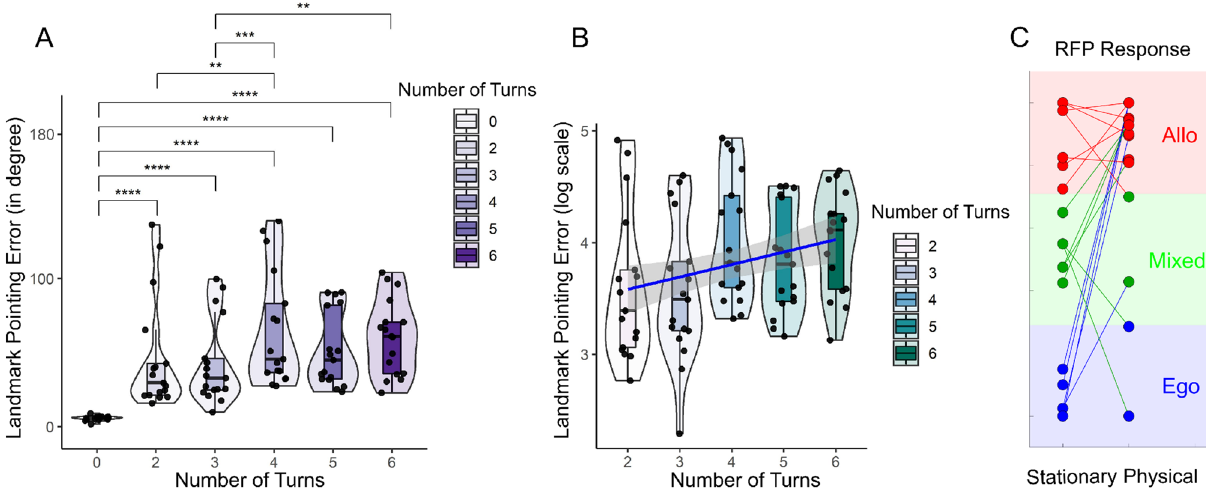
Figure 2. The results of participant behaviour. ( A ) Participant behavior in the landmark pointing task (using R software 33 ). The X axis indicates the number of turn points in the trial, the Y axis indicates the absolute error of the participants when they performed the landmark pointing task (the error was measured by the angular difference between the pointing vector and the participant to landmark vector) (*, **, ***, **** indicated for p <.05, p <.01, p <.001, p <.0001 respectively, FDR-corrected). ( B ) The result of mixed-effects model analysis (using lme4 34 , and lmerTest package 35 ), the regression was visualized by the blue line. ( C ) The RFPT results were in both the passive condition (stationary test with the tunnel paradigm) and active condition (based on the participant’s response at position 12, path 3 in the Fig. 1B). Three groups of strategies egocentric, mixed and allocentric were color coded in green, blue and red,